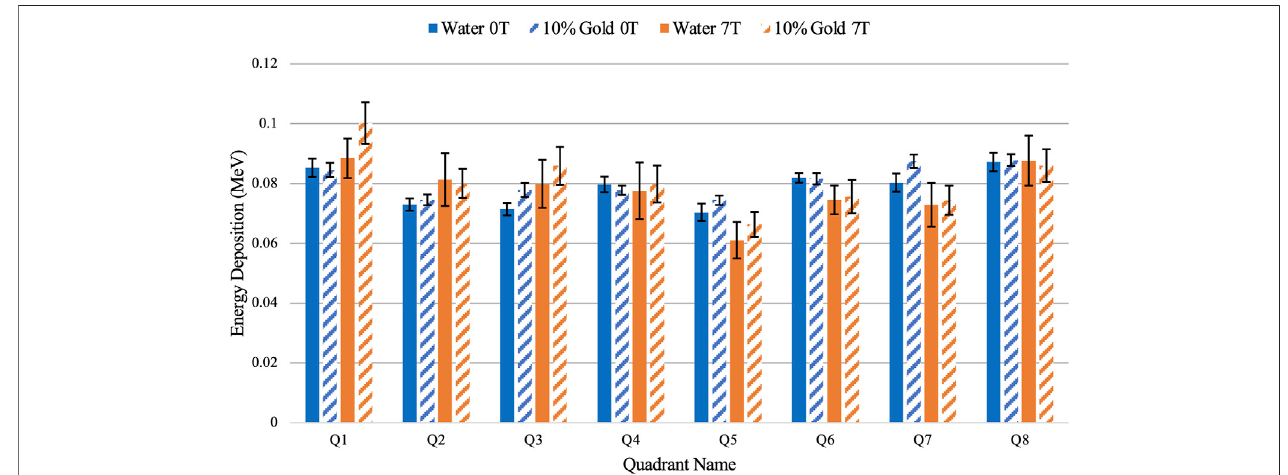
FIGURE 6 | Comparison of energy deposition in the water shell of the central alveolus between water and 10% concentration of nanoparticles using the multiple alveoli model at 0.00 and 7.00 T.